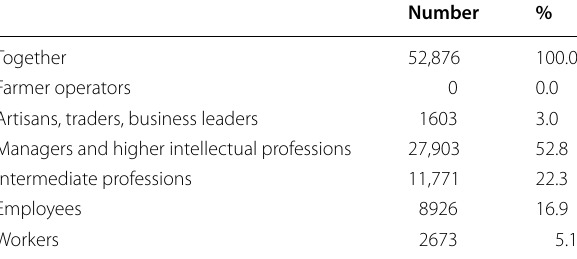
Table 1 Jobs by socio-professional category in 2018.